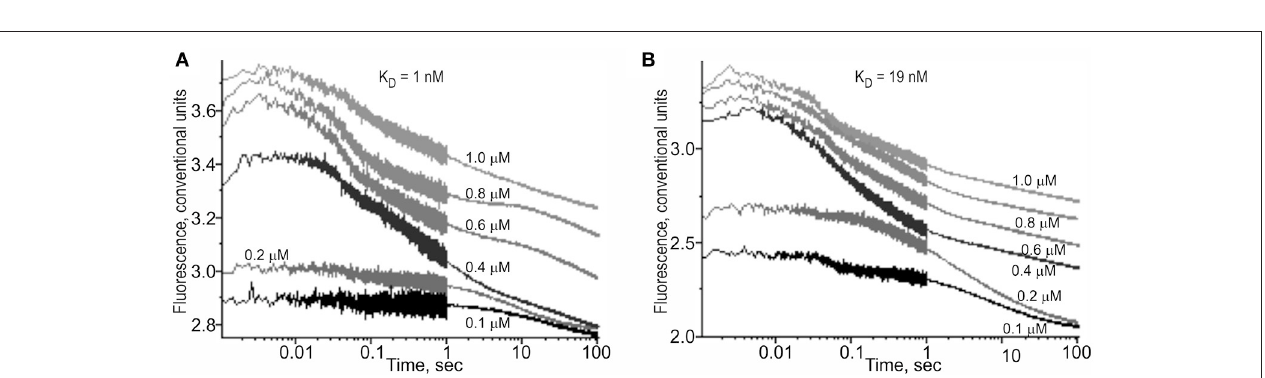
FIGURE 2 | Experimental verification of the selected candidate SNP markers by an electrophoretic mobility shift assay (EMSA) in vitro . An example of electropherograms in the case of ancestral ( A : norm, wild-type, wt) and minor ( B : minor) alleles of the candidate SNP marker rs1800202 within the human TPI1 gene promoter, which are accompanied by diagrams of experimentally measured values. (C) The significant correlations between the in silico predicted (X-axis) and in vitro measured (Y-axis) K D values of the equilibrium dissociation constant of the [TBP–ODN] complex. Solid and dashed lines or curves denote the linear regression and boundaries of its 95% confidence interval, calculated using software STATISTICA (Statsoft TM USA). Circles denote the ancestral and minor alleles of the candidate SNP markers rs563763767, rs33980857, rs34598529, rs33931746, rs33981098, rs35518301, rs1143627, rs72661131, rs7277748, and rs1800202 being verified; r, R, τ , γ , χ 2 , and α are linear correlation, Spearman’s rank correlation, Kendall’s rank correlation, Goodman–Kruskal generalized correlation, χ 2 test, and their significance, respectively; p is Fisher’s exact test two marks (A) and (B) indicate by arrows two experimental magnitudes whose measurement procedures are shown in panels A and B , respectively.